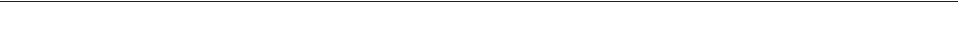
Fig. 3 Mutation signature analysis of fi ve hepatocellular carcinoma samples in different chromatin states or with different methylation levels. a Frequencies of the 96 substitution patterns of three extracted mutational signatures. The stability of the signature and the most similar COSMIC signature are shown in Supplementary Table 4. b Contribution of the three mutational signatures to each tumor sample according to the chromatin state. The y -axis indicates the number or contributions of each signature in the mutations. In each sample, signi fi cant differences were observed between active and inactive chromatin states ( P < 2.2e – 16, Pearson ’ s Χ 2 -test). The contribution of Signature B (which corresponds to COSMIC Signature 16) in active state was signi fi cantly higher than that in the inactive state ( P < 2.2e – 16, Pearson ’ s Χ 2 -test). c The contribution of three mutational signatures in genomic regions of different methylation levels. In each sample, the contribution was signi fi cantly different between high and low methylation levels ( P < 2.2e – 16, Pearson ’ s Χ 2 -test). The proportions of Signature A (which corresponds to COSMIC Signature 1) and B in highly methylated regions was signi fi cantly higher than the proportions in low methylated regions ( P < 2.2e – 16 in Sig. A, P < 2.8e – 05 in Sig. B, Pearson ’ s Χ 2 -test). d The contributions of three signatures in 15 epigenomic segments. e Odds ratio of Signature B in a particular segment compared with the other segments. * P < 0.05, ** P < 0.005, *** P < 0.0005 tested with Fisher ’ s t-test